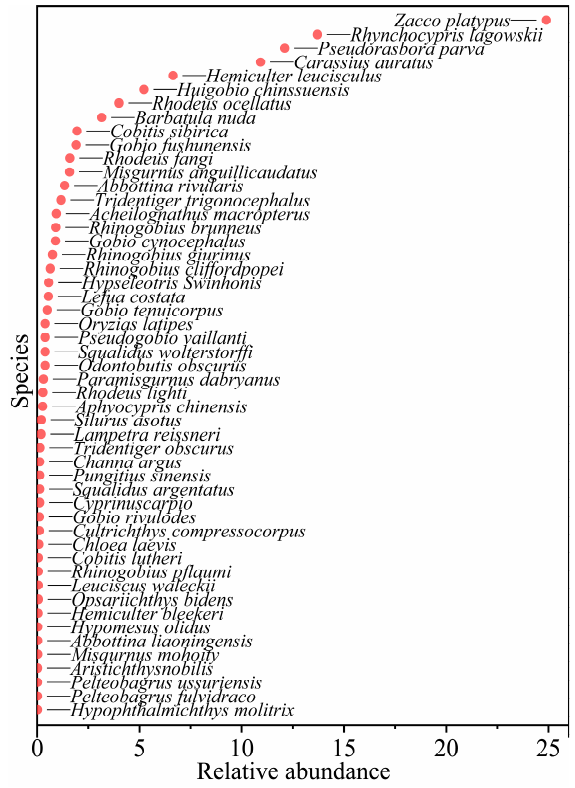
Figure 2. Fish species composition in the Hun River Basin.